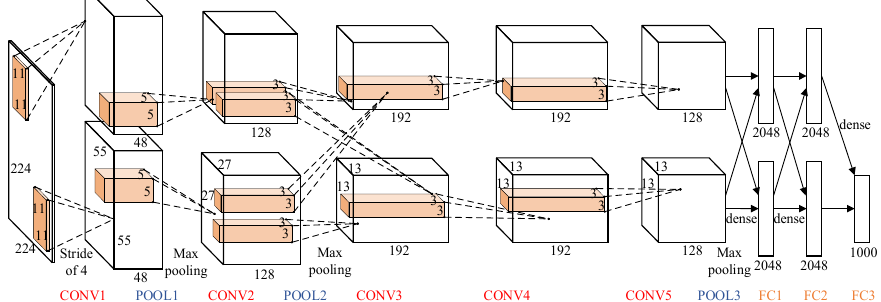
Figure 1. Network architecture of AlexNet. CONV: convolutional layer; FC: fully connected layer; POOL: pooling layer.